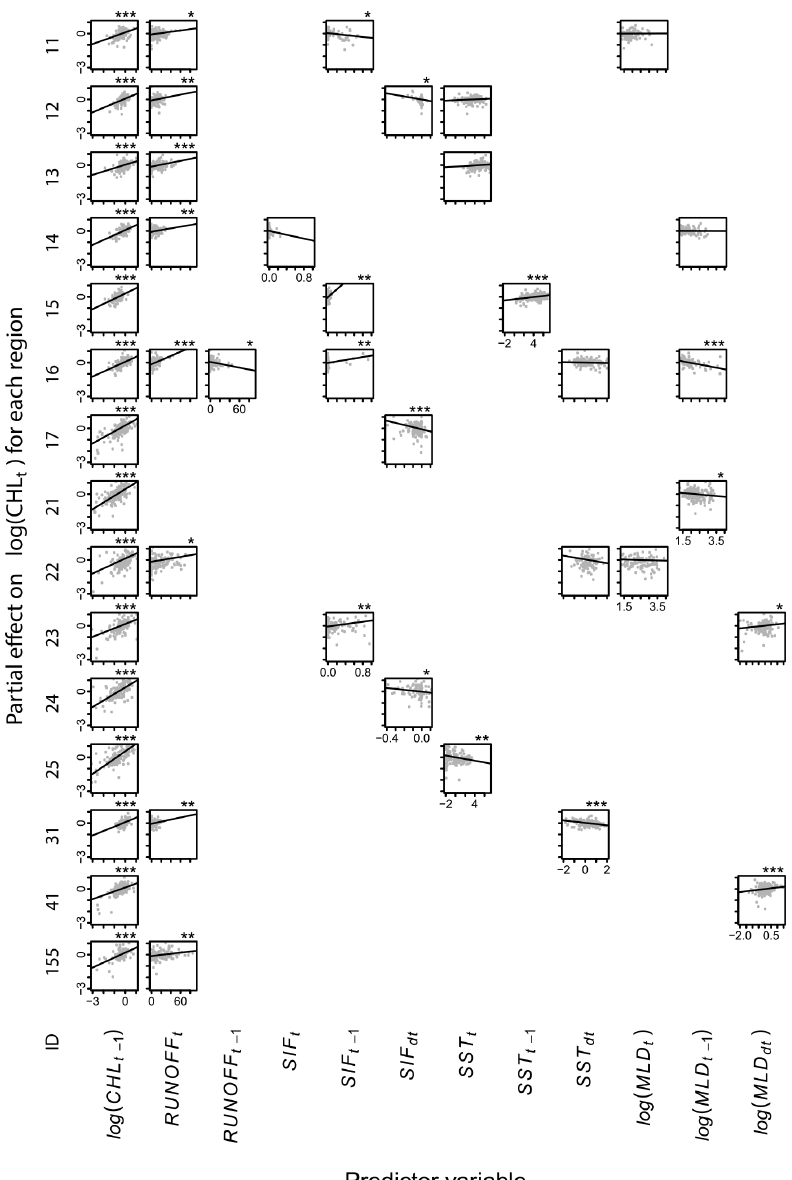
Figure A1. Partial effects of environmental variables on chlorophyll a , CHL, within 10km from the coast. Each row shows the model (Eq. 1) for one hydrological region (Table 1). Each panel shows the relationship between a predictor variable ( x axes) and CHL ( y axes), with lines showing estimated partial effects and points showing partial residuals. Blank panels imply that the variable was not selected. Asterisks show statistical significance at levels 5% ( ∗ ), 1% ( ∗∗ ) or 0.1% ( ∗∗∗